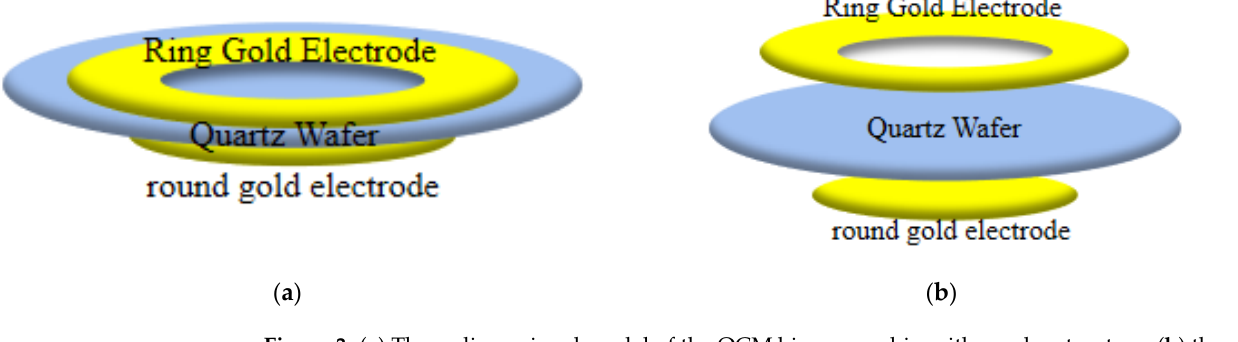
Figure 3. ( a ) Three-dimensional model of the QCM biosensor chip with a polar structure; ( b ) three- dimensional model of the QCM biosensor chip without an electrode